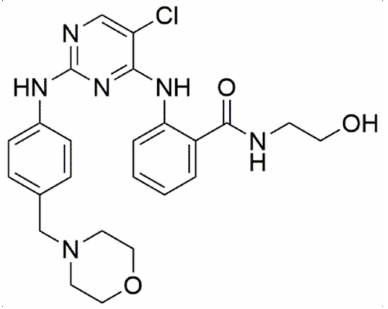
Figure 3. Structure of compound 8a .